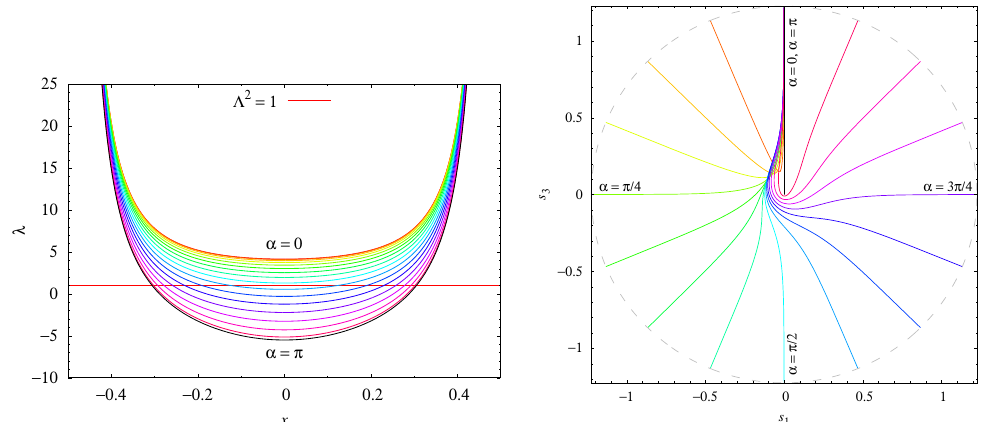
Figure 14. The same as (cid:12)gure 4 (left) and (cid:12)gure 6 (right) but for L = 1.